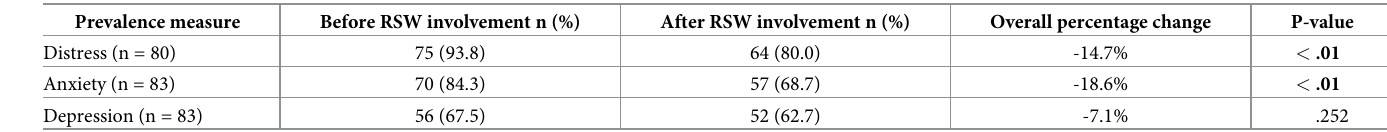
Table 2. Prevalence of emotional issues before and after RSW